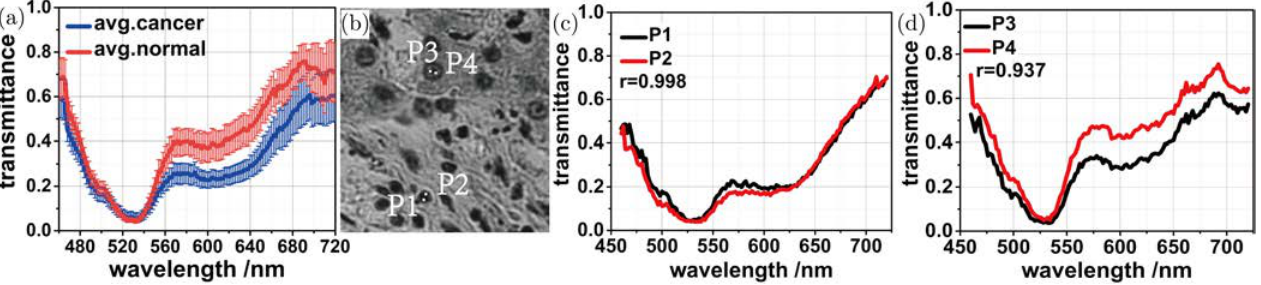
Fig. 4. (a) Average transmission spectra of cancer and normal cells. (b) Points in nucleus of cancer cell (P1 and P2) and normal cell (P3 and P4) whose transmission spectra were measured. (c) Transmission spectra at P1 and P2 and their correlation coe±cient. (d) Transmission spectra at P3 and P4 and their correlation